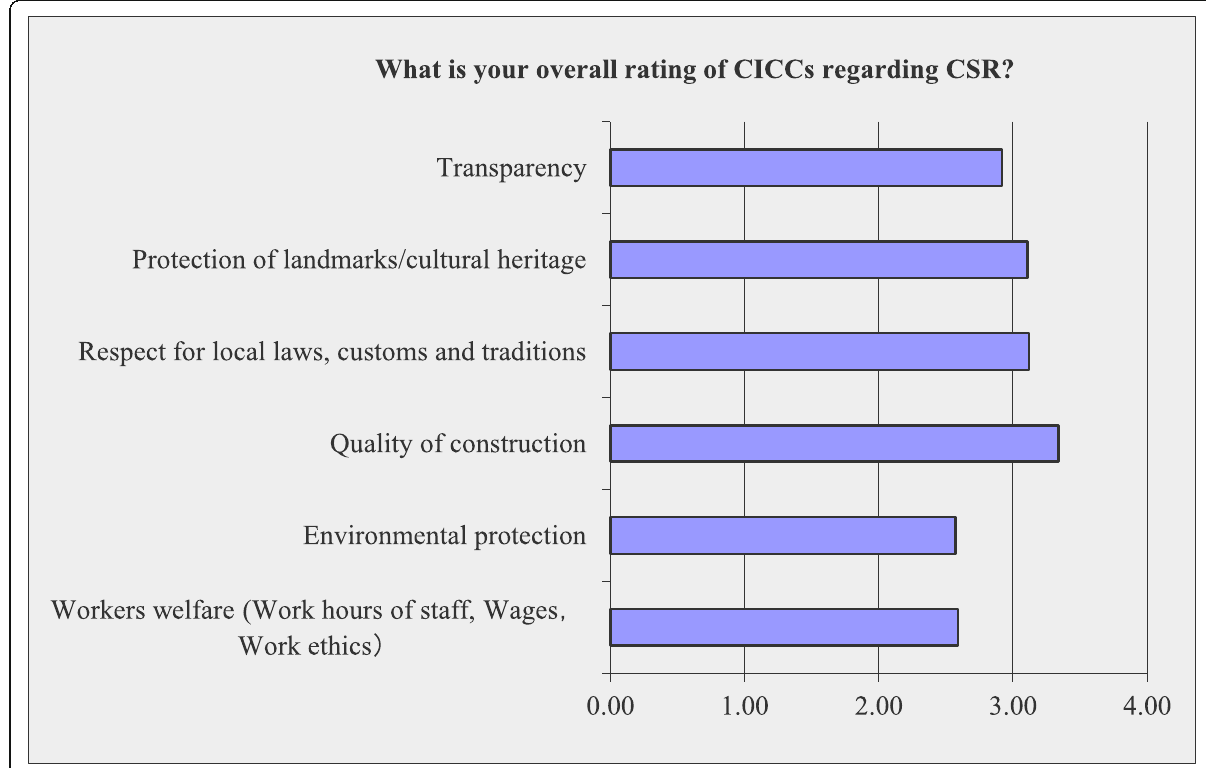
Fig. 1 Overall rating of CSR activities of CICCs by African